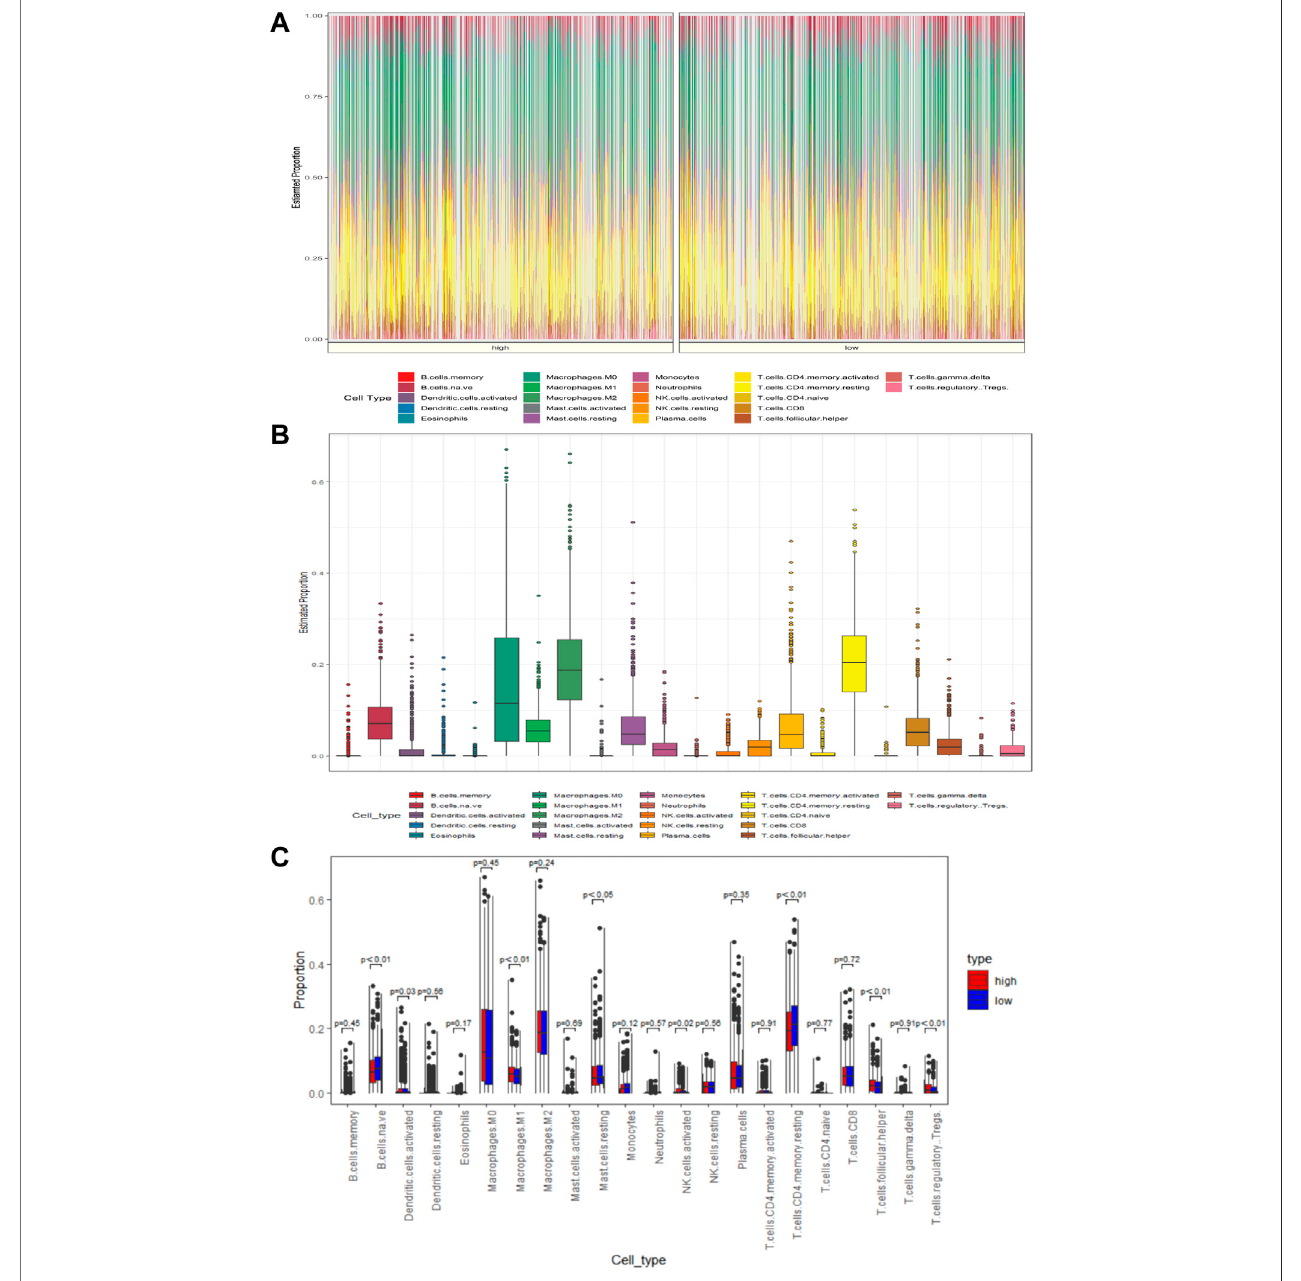
FIGURE5| MASisassociatedwithTMEimmunecellin fi ltration. (A) Heatmap ofthedifferencesinimmunecelldistribution foreachBCpatientinlow-andhigh-risk groups. (B) Histogram of the distribution of immune cells in all BC patients. (C) Differences in the distribution of immune cells in low- and high-risk groups.